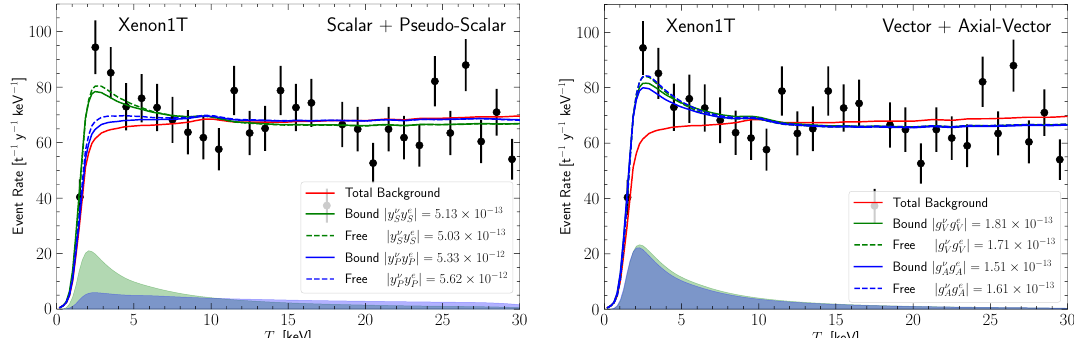
Figure 6 . Total events (black points) and background (red curve) of XENON1T’s data, we fit the data by solar neutrino-bound electron scattering with a sterile neutrino in final state, in addition to both scalar (green) and pseudo scalar(blue) mediators. All three parameters m s , m φ , | y e y p | are using the best-fitting